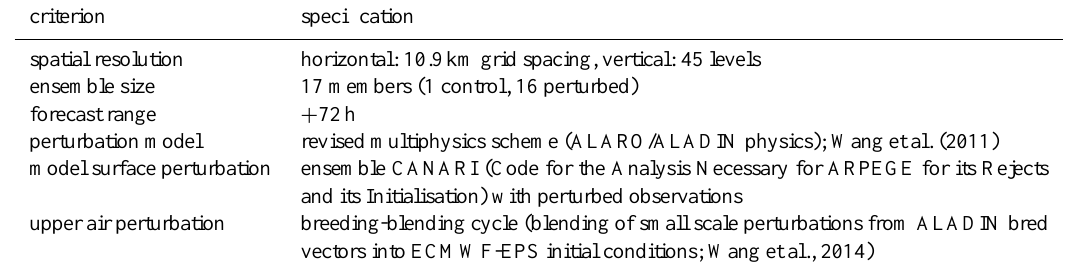
Table 1. Key specifications of the ALADIN Limited Area Ensemble Forecasting (LAEF)